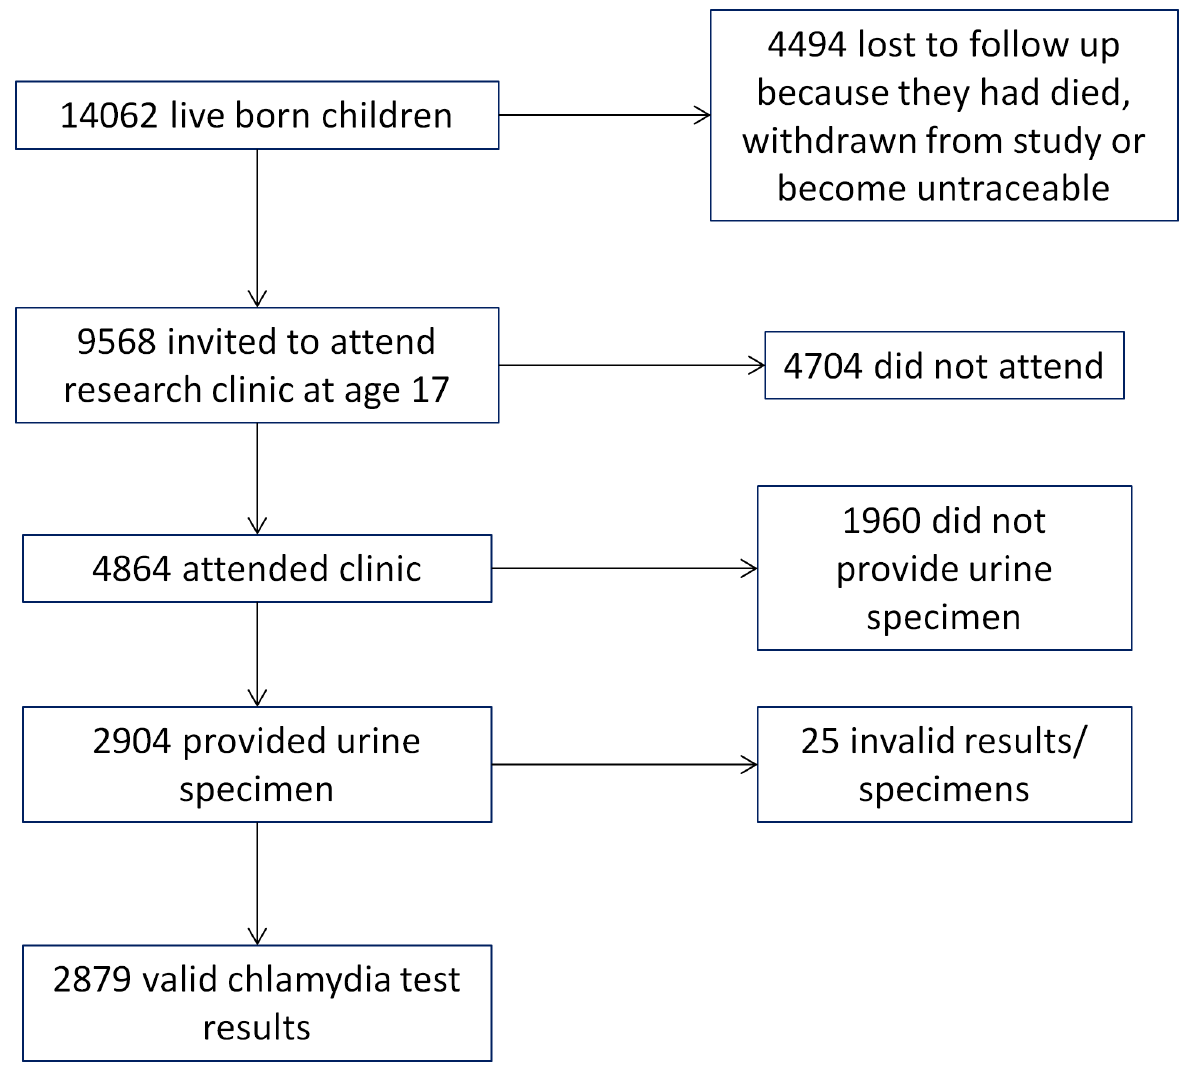
Figure 1. Flowchart of inclusion and attrition from ALSPAC chlamydia prevalence study.